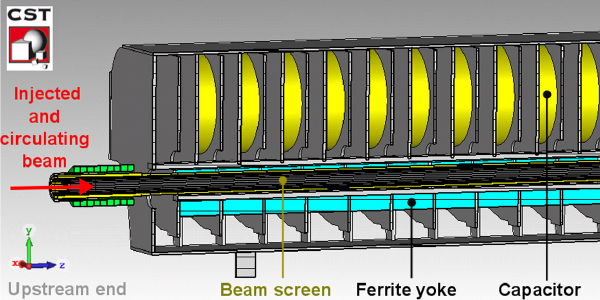
magnets.FIG. 2. A CST model of a 20-cell FCC-hh injection kicker magnet — the first 10 cells at the upstream end are